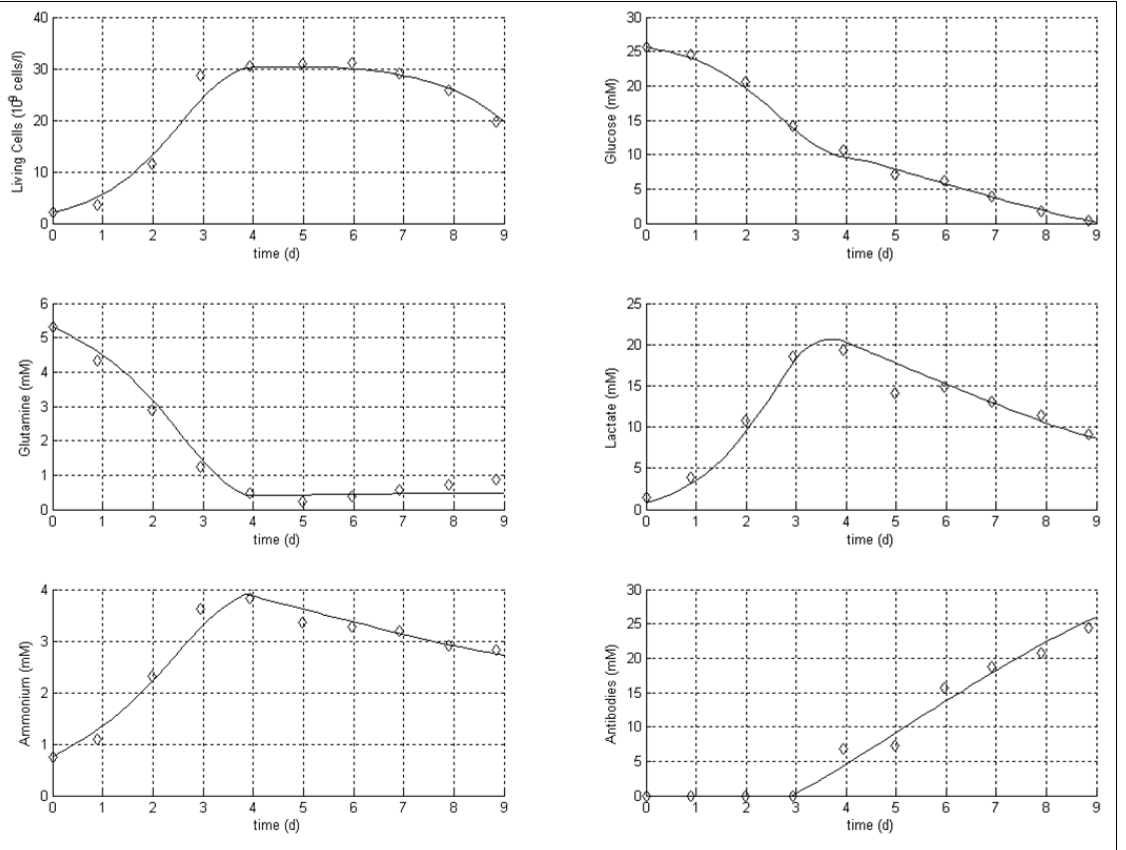
Figure 28: Results of the parameter optimization